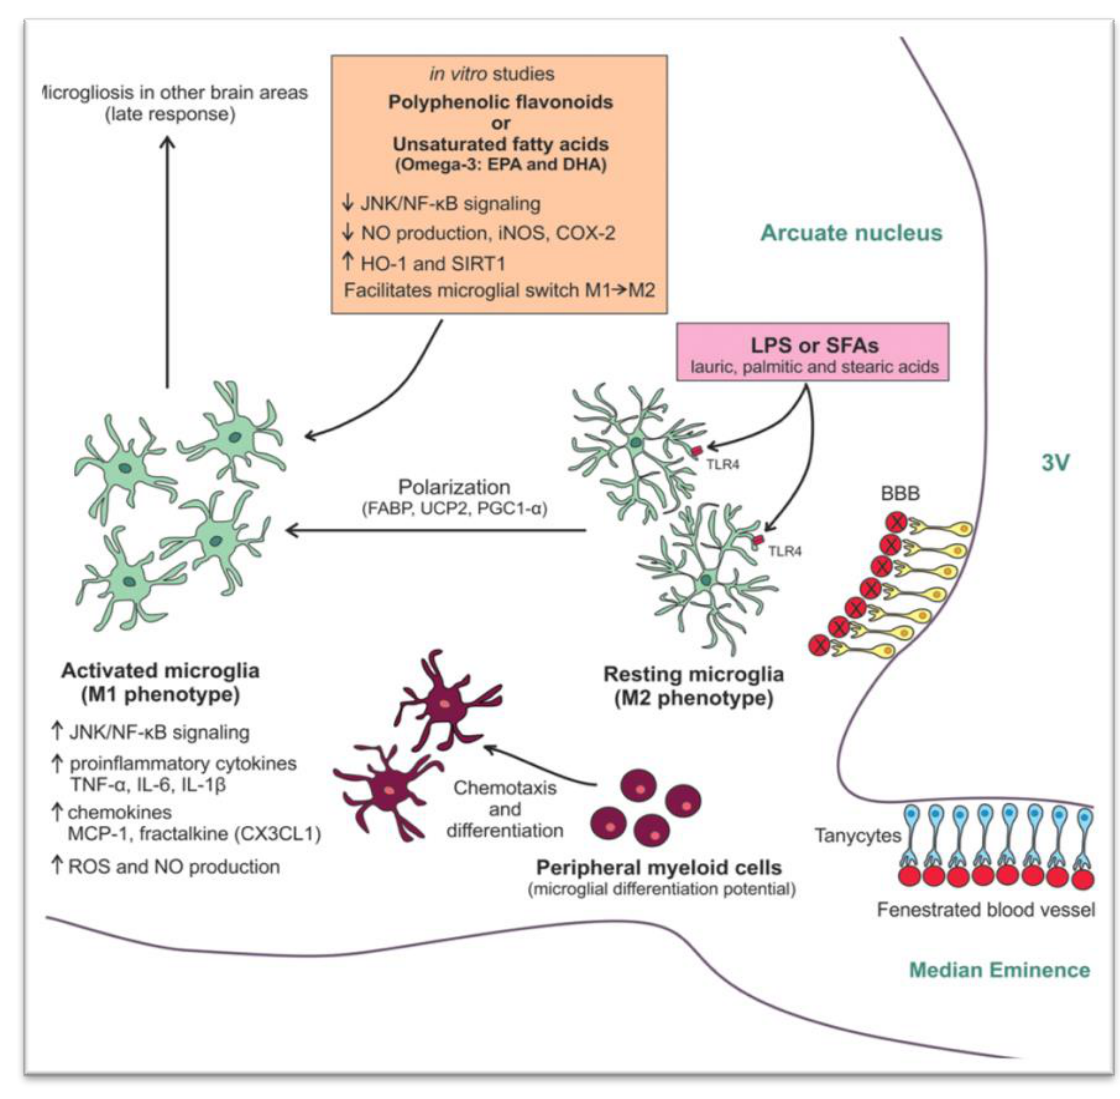
Figure 2. Mechanisms involved in the high fat diet (HFD) -induced hypothalamic microgliosis at molecular level [82]. Reproduced with permission from Licio A. Velloso, Hypothalamic Microglial Activation in Obesity: A Mini-Review; published by frontiers in Neuroscience, 2018.